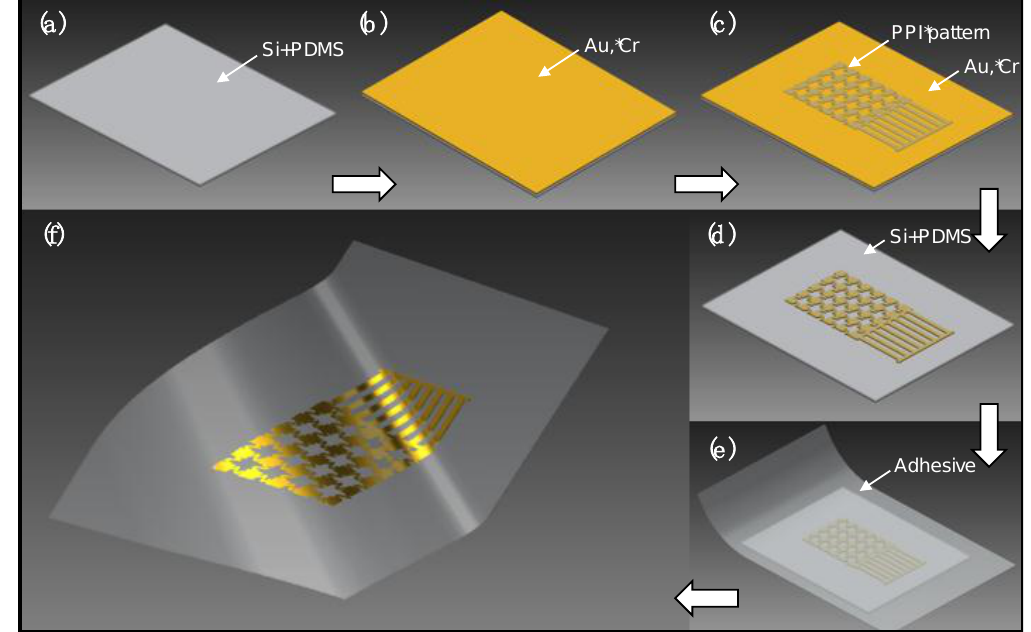
Figure 1. Example of TP vs. AP processes. ( Top ) TP process steps, starting with Si donor substrate. Includes procedures such as depositing a sacrificial layer, using solvent for stripping sacrificial layer, and transfer printing by an intermediate elastomeric substrate; ( Bottom ) AP process obviates the need for sacrificial layer, use of solvents, or use of an intermediate elastomer for transfer printing. Instead, a weakly-adhering donor is used, from which reversed metallization and a combined polymer deposition and photolithography step are implemented to create an inverted sensor. Because the sensor is inverted on a weakly-adhering surface, peel-off is performed directly by adhesive. Both processes result in a similar sensor embedded within adhesive; the latter requires fewer steps and materials.